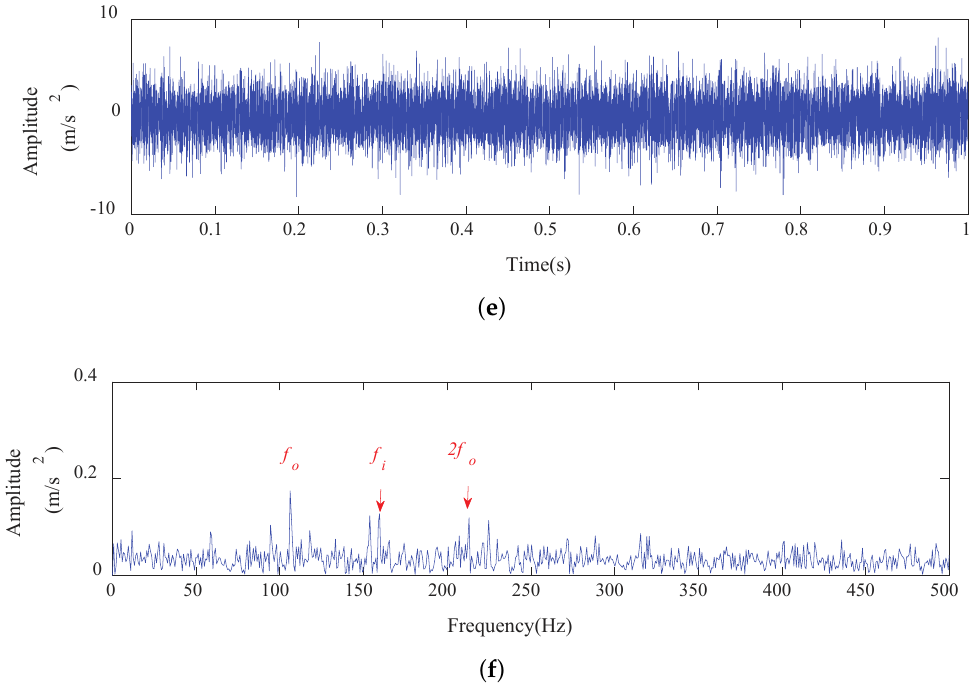
Figure 13. Time-domain waveform and frequency spectrum of the single fault signals and the mixed signal: ( a ) Time-domain waveform of inner race fault signal. ( b ) Envelope spectrum of inner race fault signal. ( c ) Time-domain waveform of outer race fault signal. ( d ) Envelope spectrum of outer race fault signal. ( e ) Time-domain waveform of the mixed signal. ( f ) Envelope spectrum of the mixed signal.